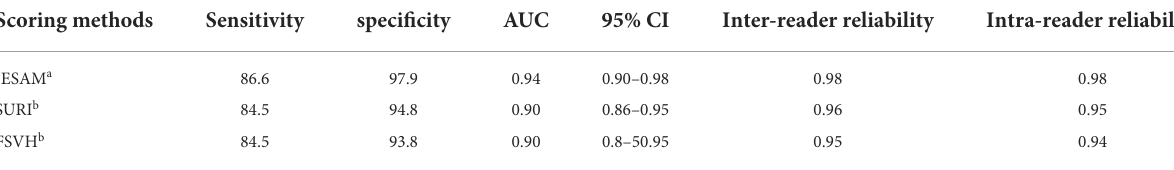
TABLE 3 Sensitivity and specificity of three scoring methods for the diagnosis of Ménière’s disease by magnetic resonance endolymphatic hydrops imaging. Scoring methods